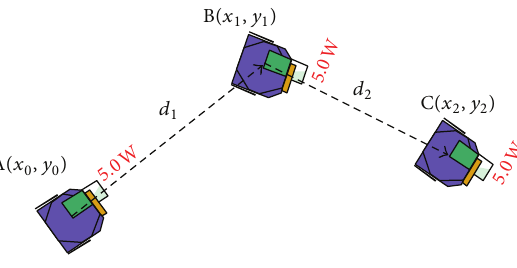
Figure 8: Traveling distance of mobile